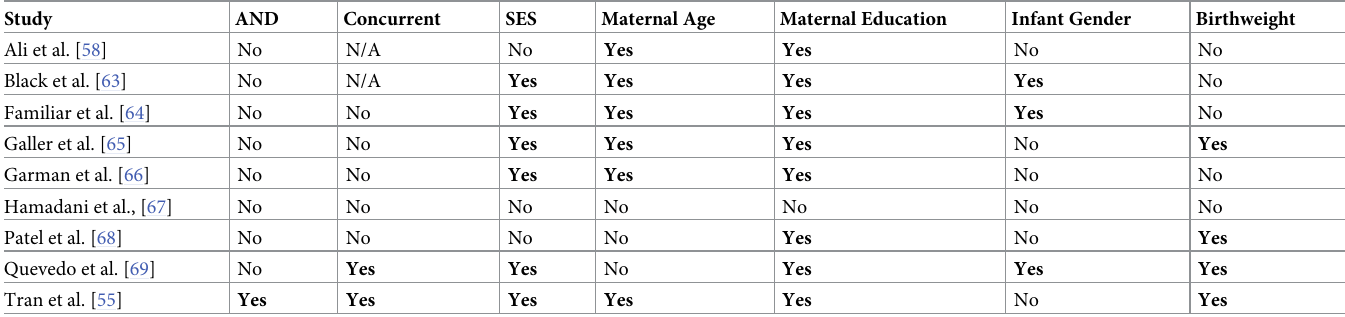
Table 4. Key a priori adjustment variables identified for postnatal studies.